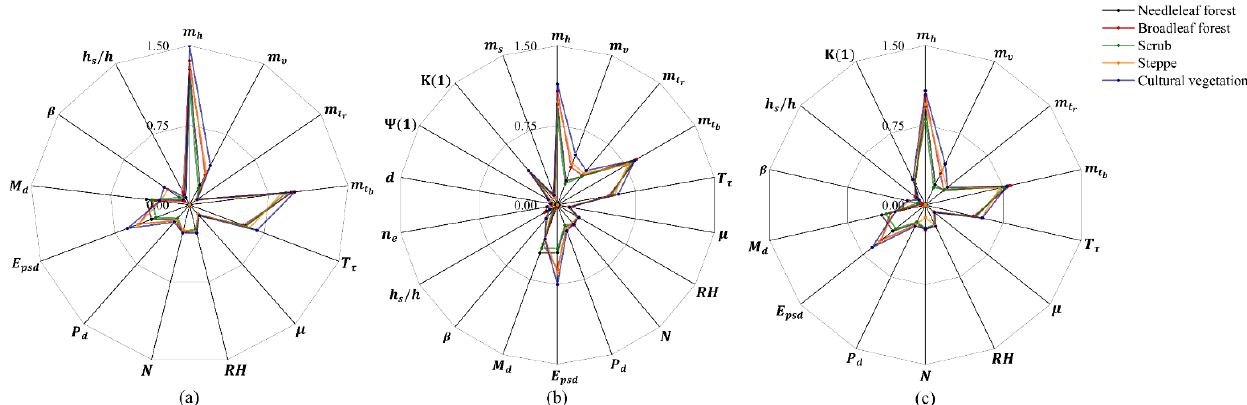
Figure 5. Sensitivity coefficient distribution of M 0 for diverse vegetation and soil texture types to input parameters. The soil texture of this area is simulated as sandy loam in part ( a ); the soil texture is simulated as loam soil in part ( b ); and the soil texture is simulated as loamy clay, clay loam, or sandy clay loam in part ( c ).